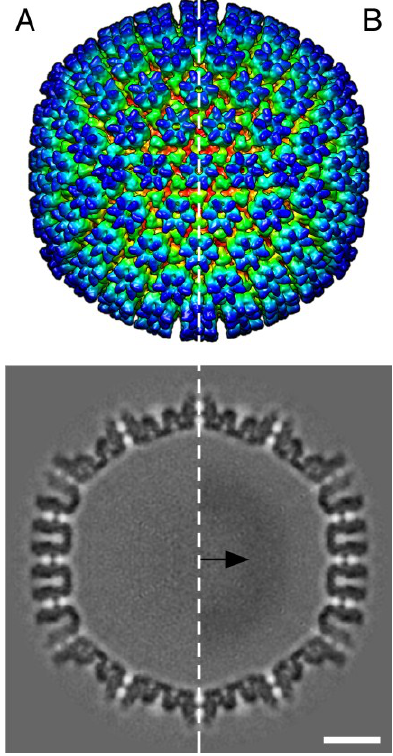
Figure 6. Cryo-EM reconstructions of the HCMV A- (( A ), left panel) and B-capsids (( B ), right panel). These two capsid types appear to be identical at this resolution. Surface views are shown on the top panels and sections are shown below. The arrow indicates the B-capsid “core” of poorly organized scaffold remnants that are icosahedrally blurred into the dark ring. A-capsids lack this internal density. Scale 20